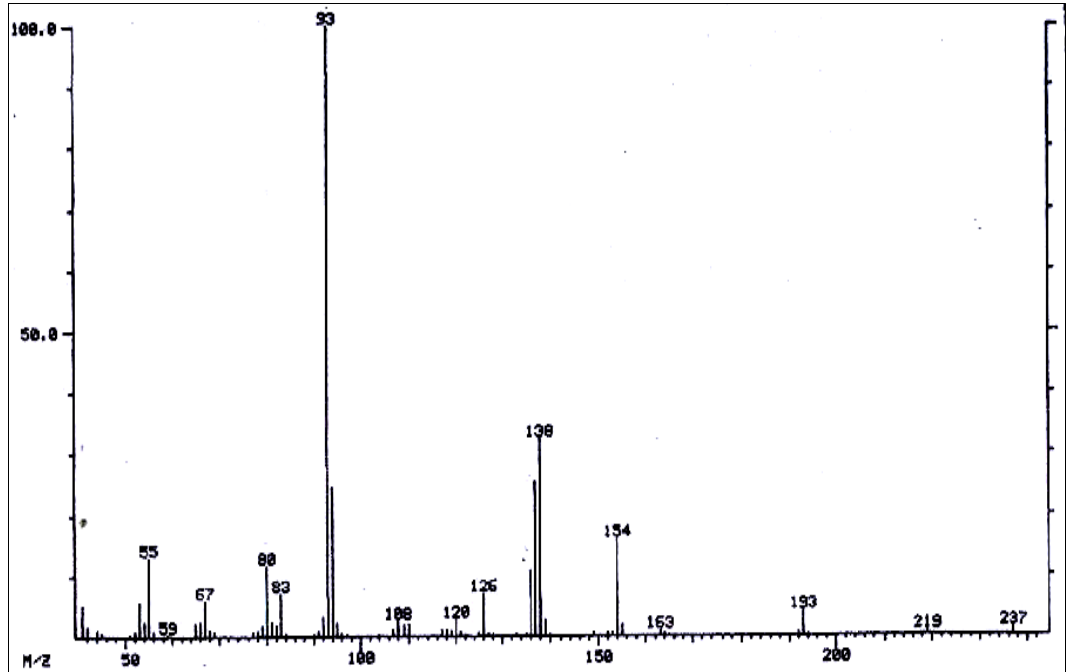
Figure 7. Mass spectrum of 9-angeloyl or 9-tigloylretronecine 9-angeloyl or 9-tigloylheliotridine.